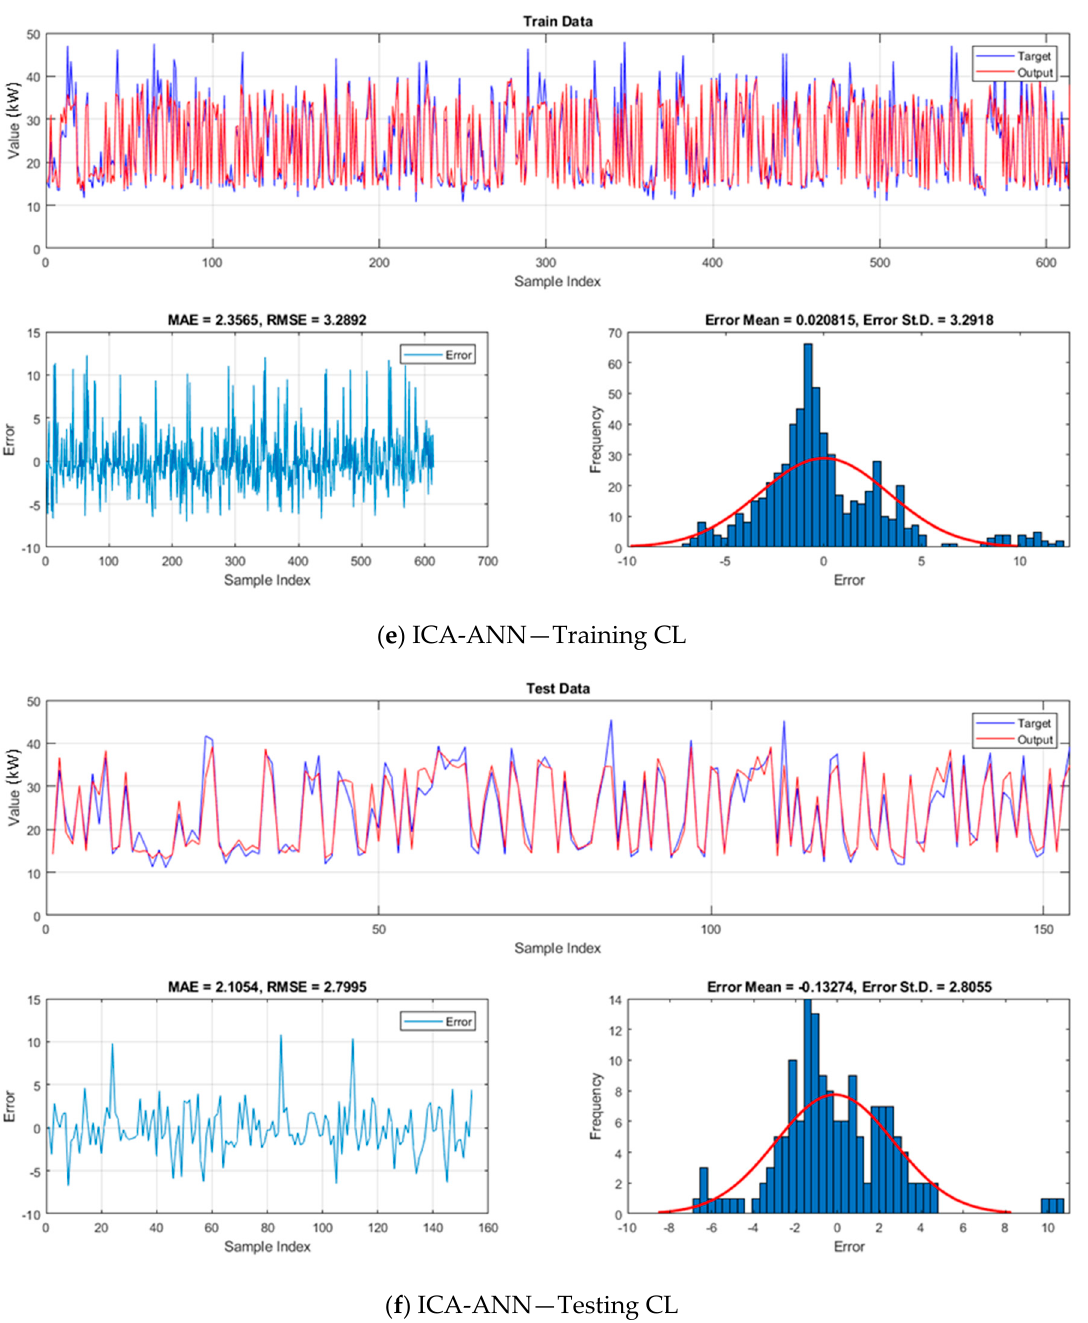
Figure 12. A graphical view of the obtained results and the calculated errors for CL prediction.